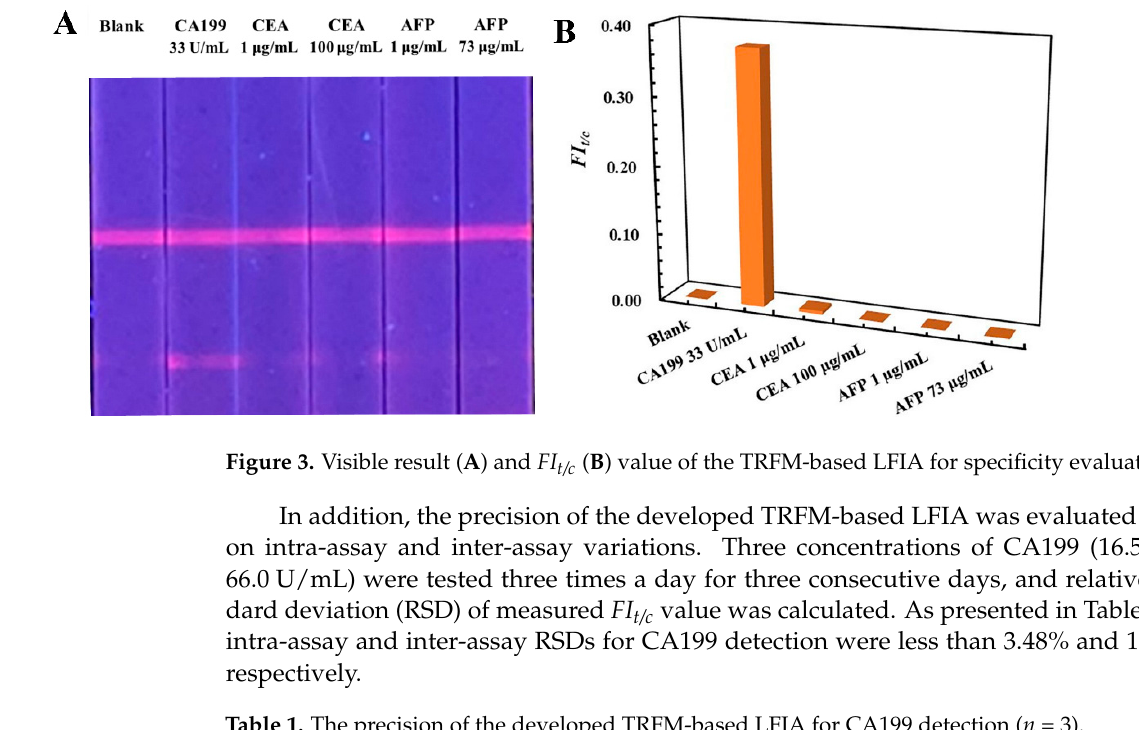
Table 1. The precision of the developed TRFM-based LFIA for CA199 detection ( n =